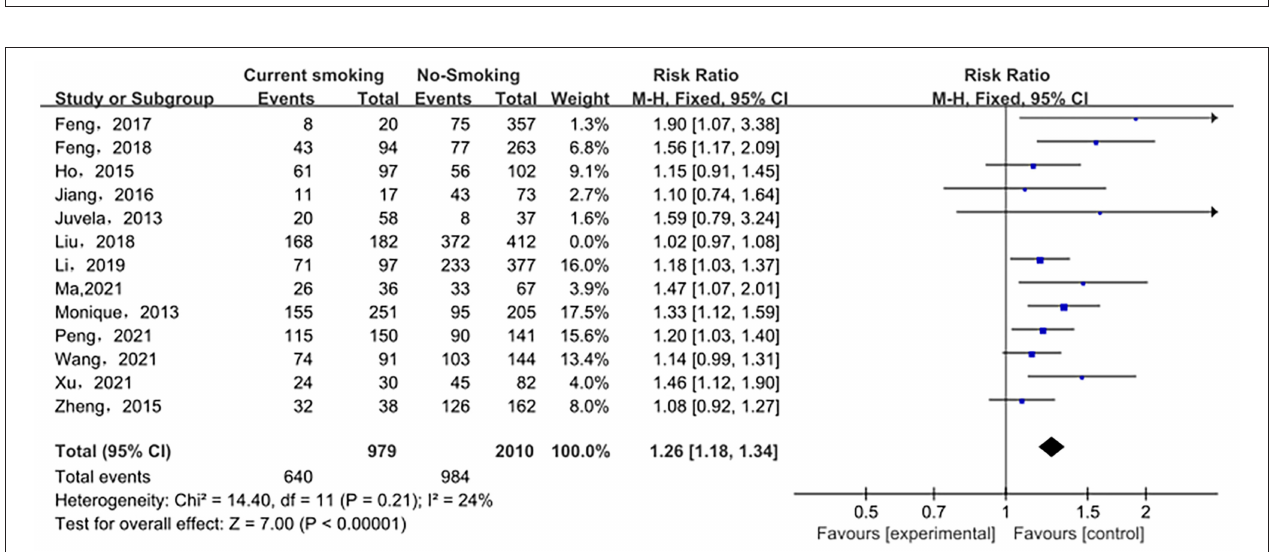
FIGURE 4 | A Forest plot of the current smoking and the former smoking groups.